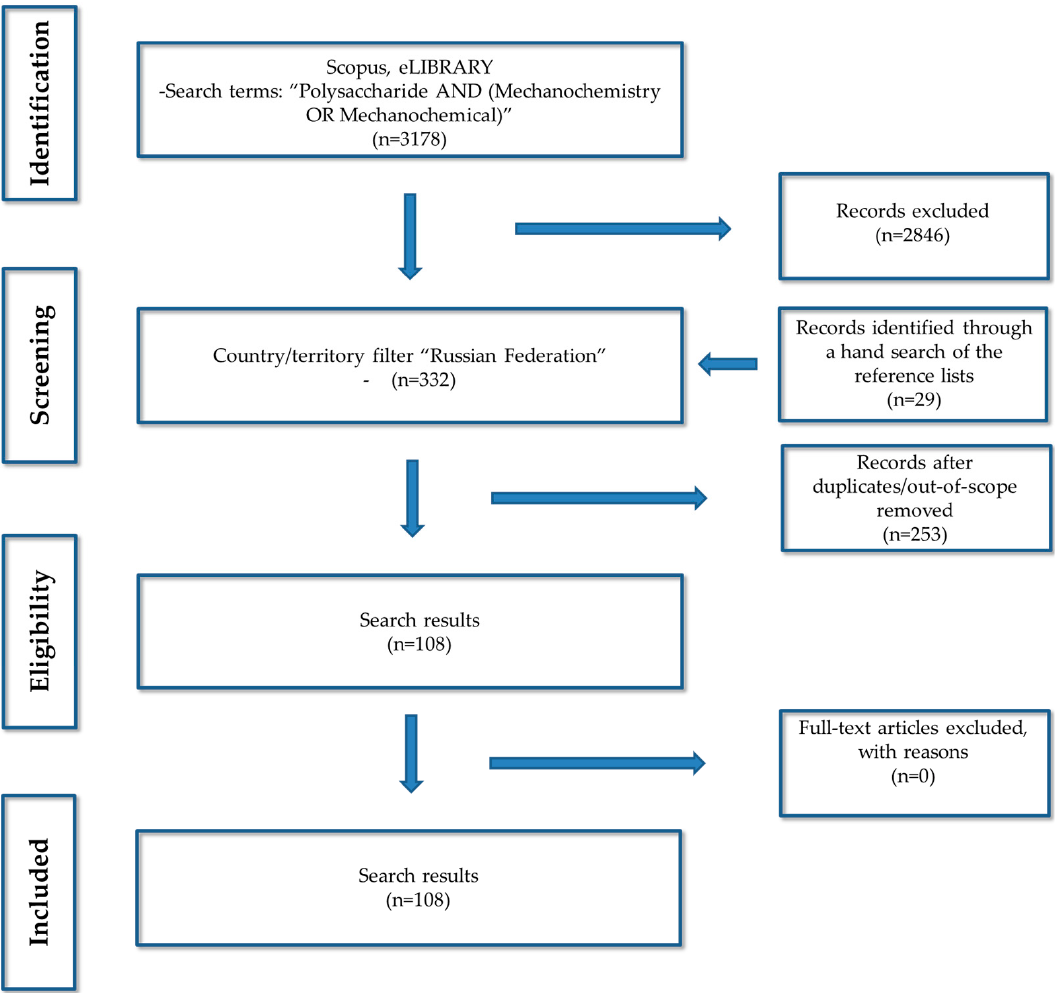
Figure 1. The PRISMA flow diagram.